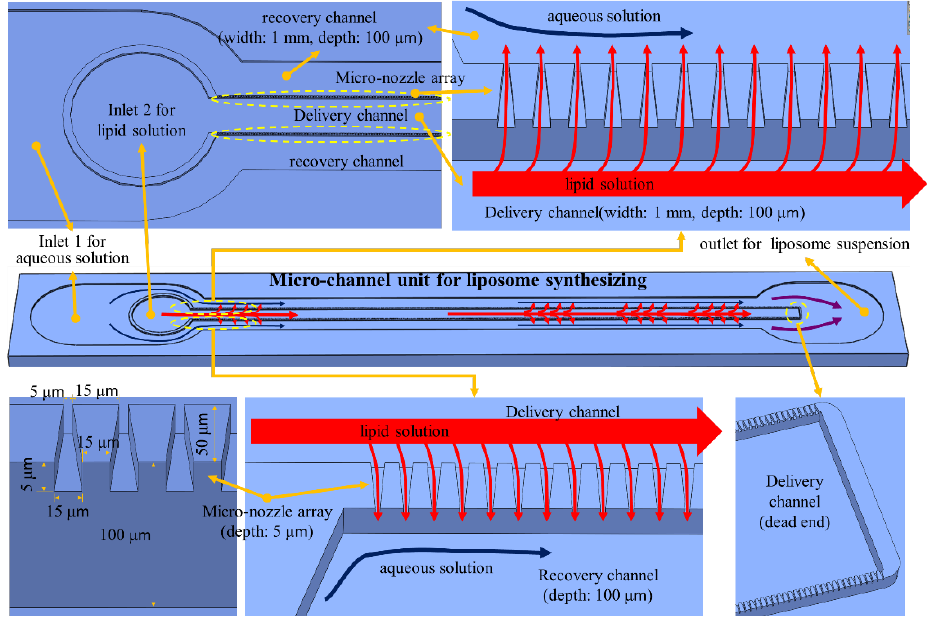
Figure 3. Schematics and design for a unit liposome-synthesizing micro-channel.